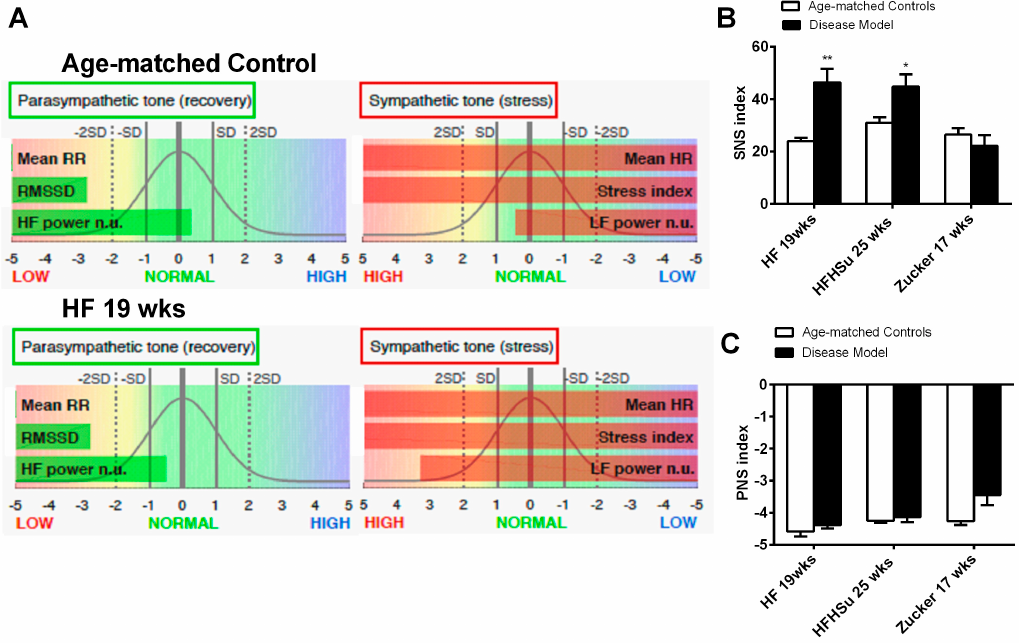
Figure 6. Effect of hypercaloric diets and genetic deletion of leptin receptors on sympathetic activity evaluated by spectral analysis of the heart rate. ( A ) shows representative experiments of power spectral density (PSD) calculated in control, in HF 3 weeks, and in HF + STZ animals. ( B , C ) Autonomic function assessed by the ratio between the percentage of low frequencies (LF) that represents the sympathetic component of the autonomic nervous system and the percentage of high frequencies (HF) that represents the parasympathetic component of the autonomic nervous system. Frequencies are presented in normalized units. All groups of hypercaloric diet animals and their aged-matched controls as well as Zucker diabetic rat and its lean controls of 17 weeks included 6–8 animals per group; Zucker diabetic rat of 23 weeks included 3 animals per group, and its lean control only one animal. Bars represent means ± SEM; two-way ANOVA with Bonferroni’s multiple comparisons test: * p < 0.05 and ** p < 0.01 comparing age-matched controls with disease models.